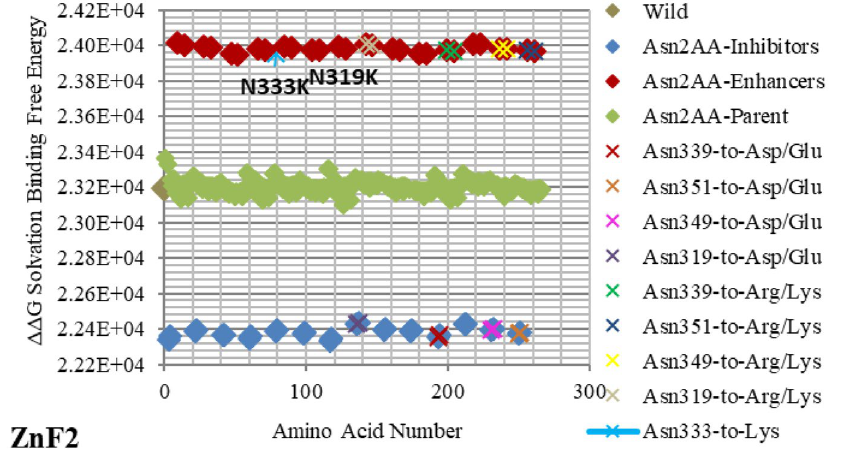
Figure 3. Electrostatic free energy differences of Asparagine (Asn/N) within GATA3:DNA complex. Plot presents the solvated binding free energy calculations (in KJ/mol) of GATA3 Asn amino acid mutants in both of Chain-D and Chain-C.